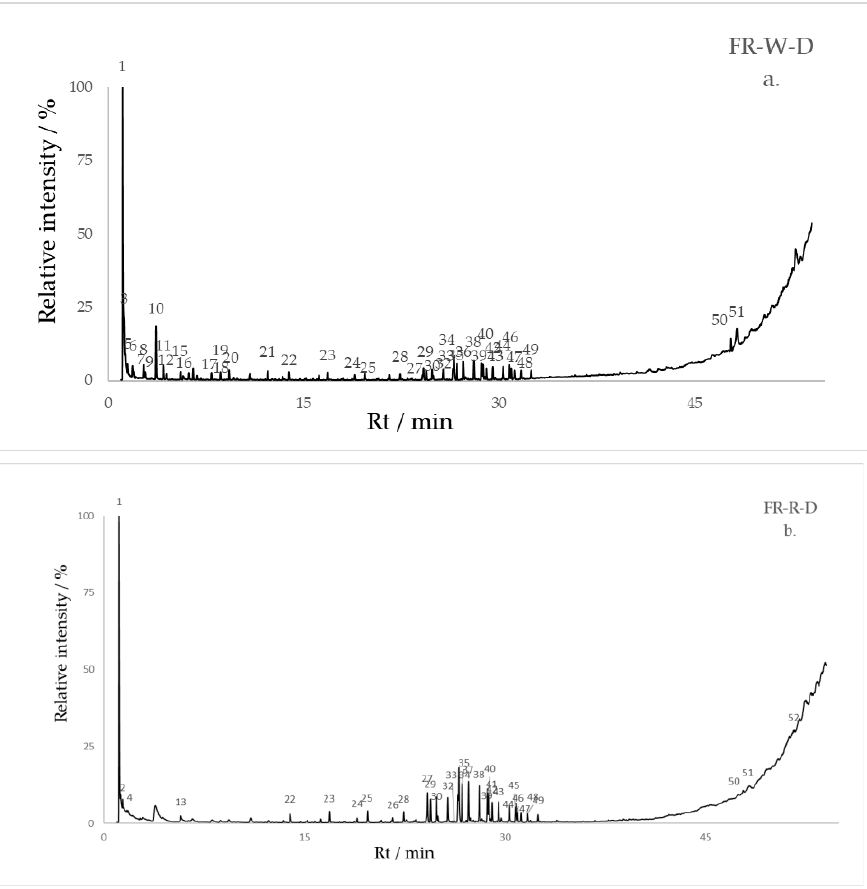
Figure 10. Chromatograms of FRs after ( a ) washing in detergent and ( b ) rinsing.